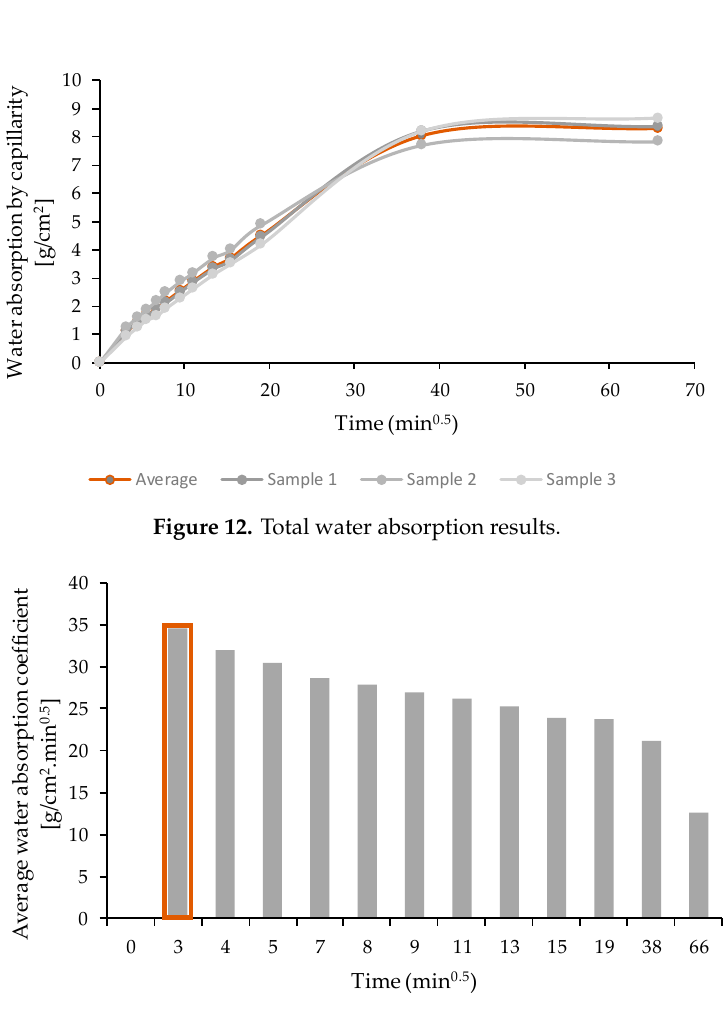
Figure 13. Variation of the average water absorption during the test period.